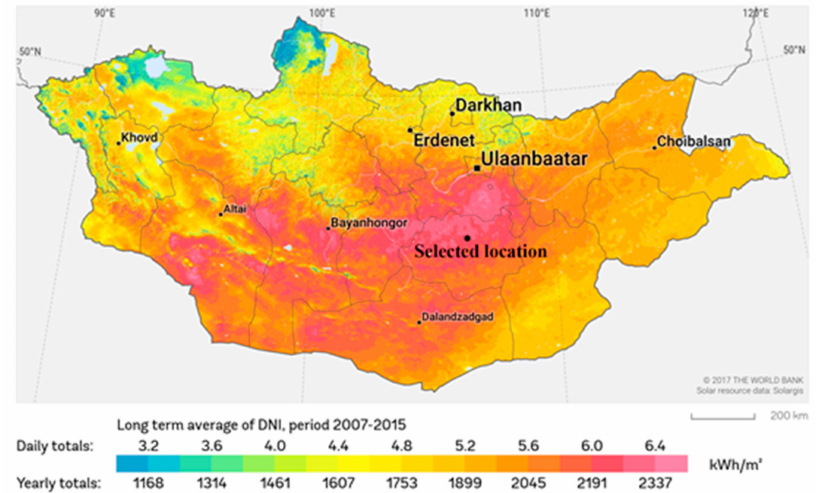
Figure 3. Direct normal irradiation in Mongolia via Solargis